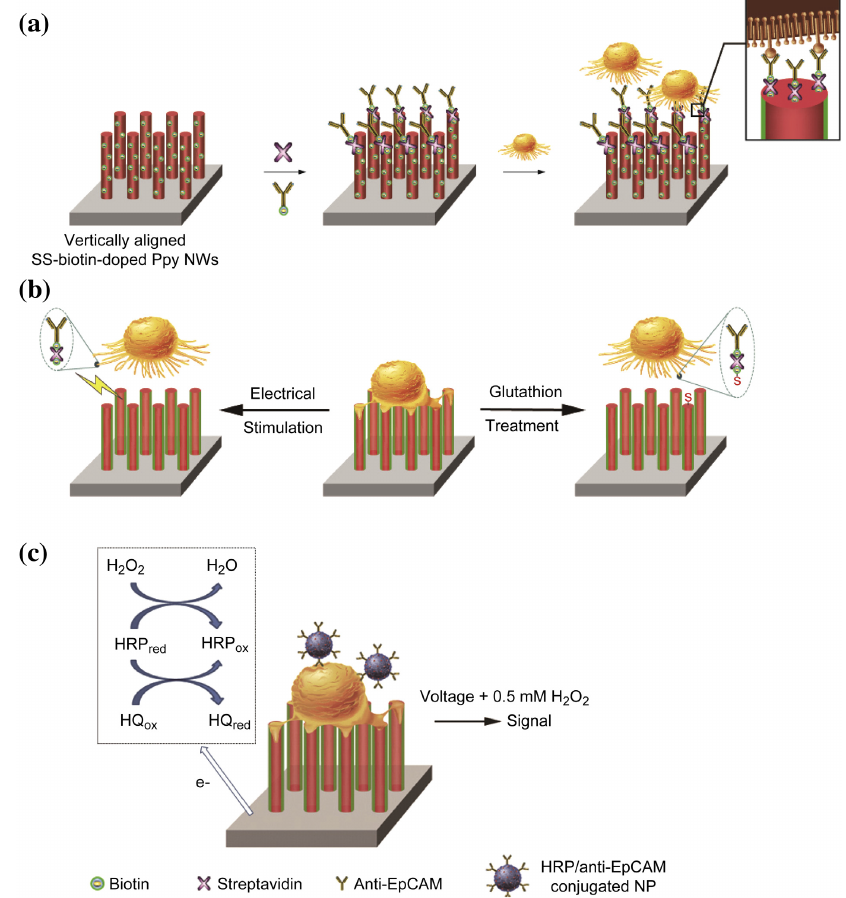
Figure 9. ( a ) Composition of the cell capture array: disulfide-biotin has been doped into the vertical PPy nanowires during electrochemical polymerization and linked to the biotin-linked anti-EpCAM antibodies through addition of streptavidin. ( b ) Captured cells can be released either by applying a voltage swelling the PPy or the addition of glutathione for cleavage of the disulfide bond. ( c ) Electrochemical detection after labeling of captured cells with HRP-nanoparticle-linked antibodies. Reprinted from [45], Copyright 2014, with permission from